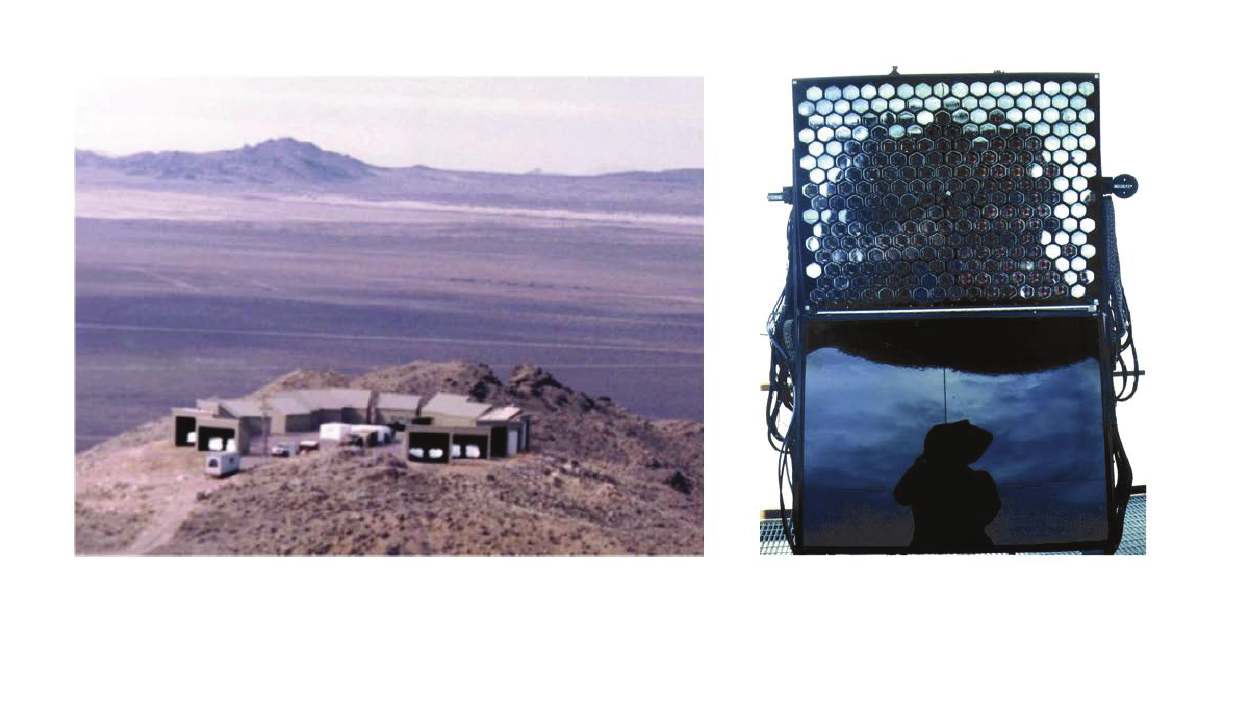
Figure 8. HiRes Camel’s Back detectors (L); HiRes pmt array and optical filter panel